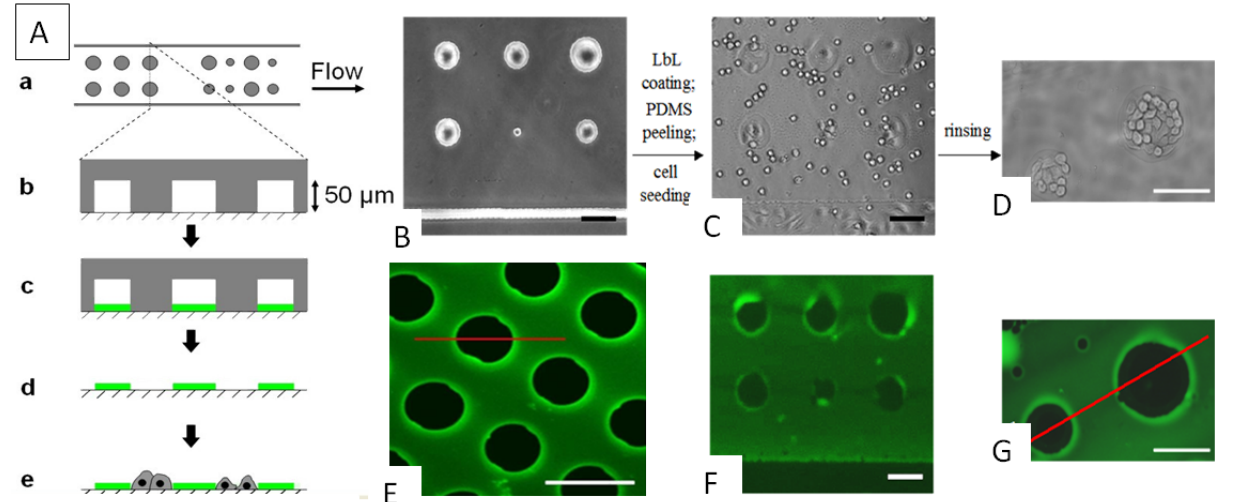
Figure 6. ( A ) Schematics of the patterning of (HA/PLL) soft film in a microfluidic 24 channel. ( a ) The top-view of channel region with spherical structures; ( b ) Cross-section of the region indicated by dotted lines (side view); the glass is at the bottom and PDMS pillars on the glass; ( c ) Multilayer deposition in the empty regions in the channel. ( d ) Deposited patterned LbL film after PDMS stamp removal; ( e ) Selective cell growth on uncoated (patterned) film areas; and ( B ) Phase-contrast image of the channel before LbL deposition; ( C ) Phase-contrast image of the region after film assembly followed by PDMS stamp removal and subsequent seeding of L929 fibroblasts (2 h incubation); ( D ) Phase-contrast image of zoomed region of the channel after 6 h pre-incubation followed by cell rinsing; ( E ) CLSM image showing the pattered film before PDMS removal; and ( F , G ) Fluorescence images of ( C ) and ( D ), respectively. The scale bar is 100 µm in all cases. Adopted from